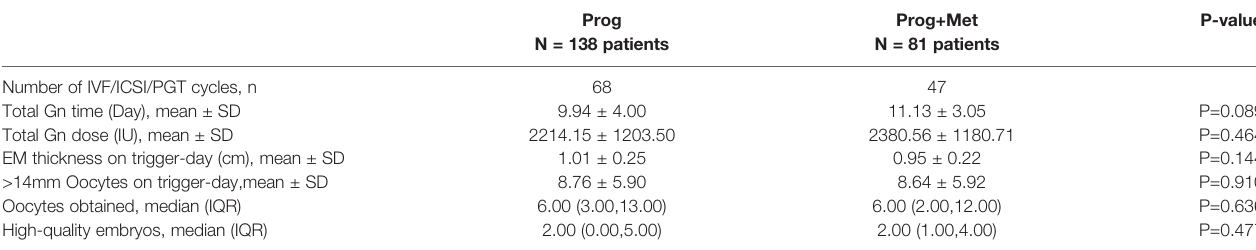
TABLE 5 | Characteristics of IVF-ICSI-PGT stimulation cycles and embryological results.